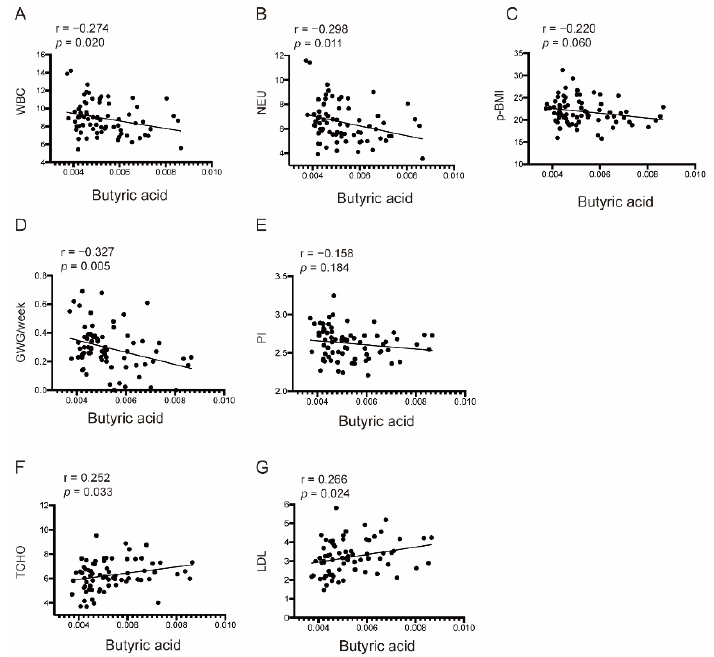
Figure 4. Correlation analysis between acetic, propionic, and butyric acid contents and clinical indicators in T3. ( A – C ) Associations between acetic acid and WBC, NEU counts or LDL level in either group. ( D , E ) Associations between propionic acid and insulin level or p -BMI in either group. ( F ) Associations between butyric acid and GWG ratio in either group.